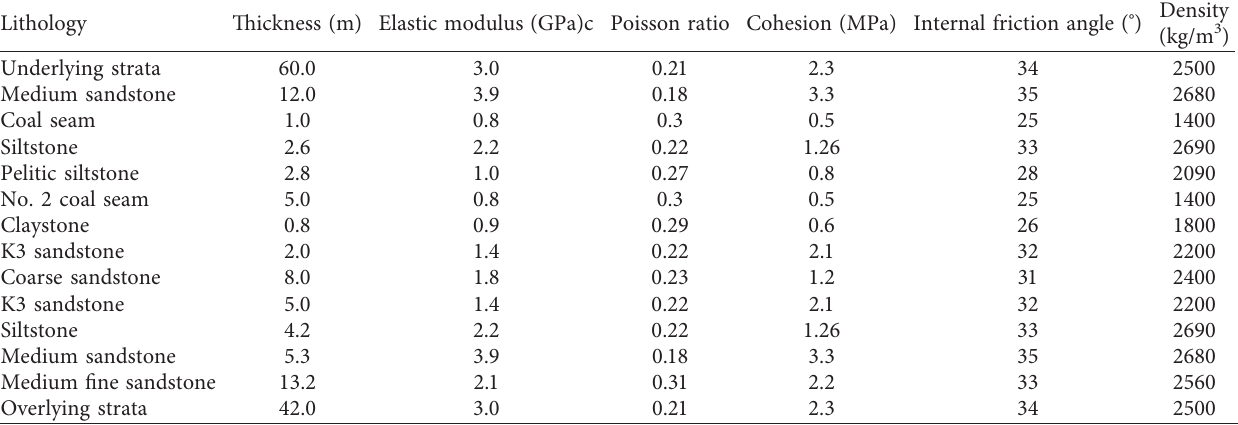
Figure 1: Numerical calculation model diagram. (a) Overall drawing of model; (b) partial enlarged Table 1: Mechanical parameters of coal and rock.